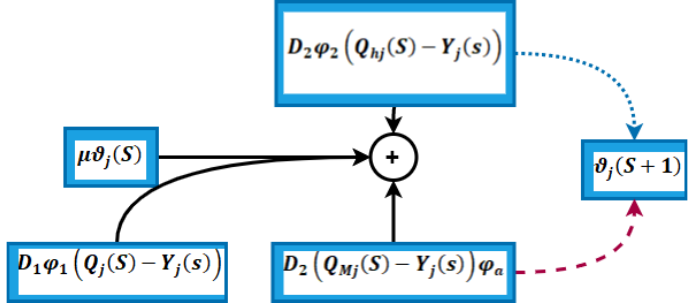
Figure 2. Particle